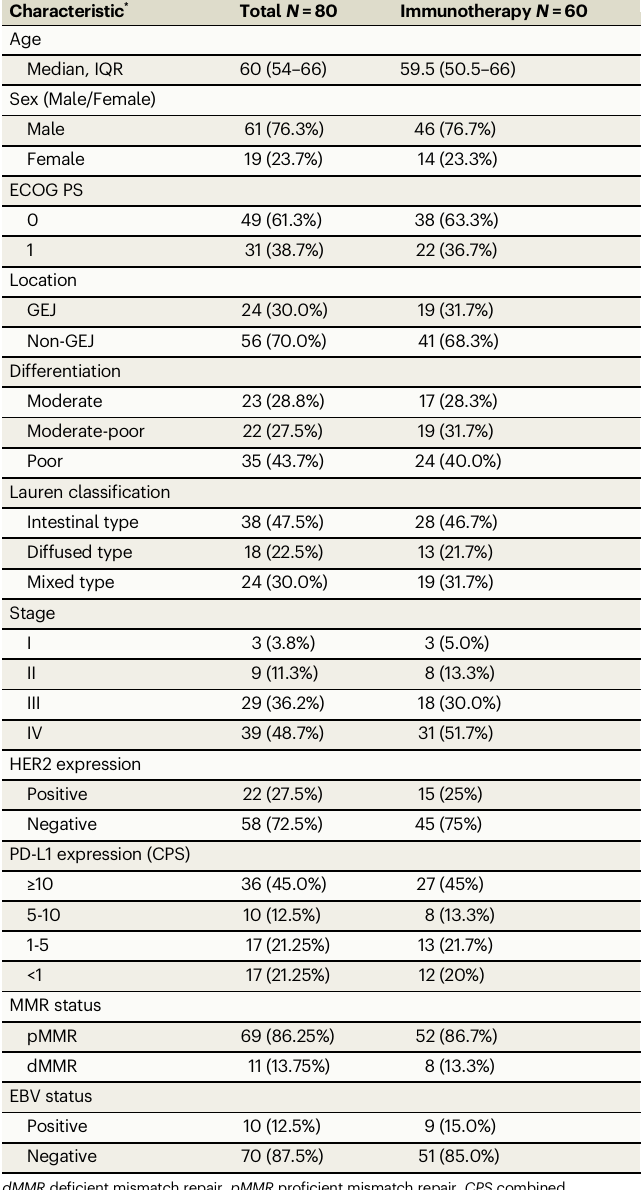
Table 1 | Baseline characteristics of gastric cancer patients Characteristic